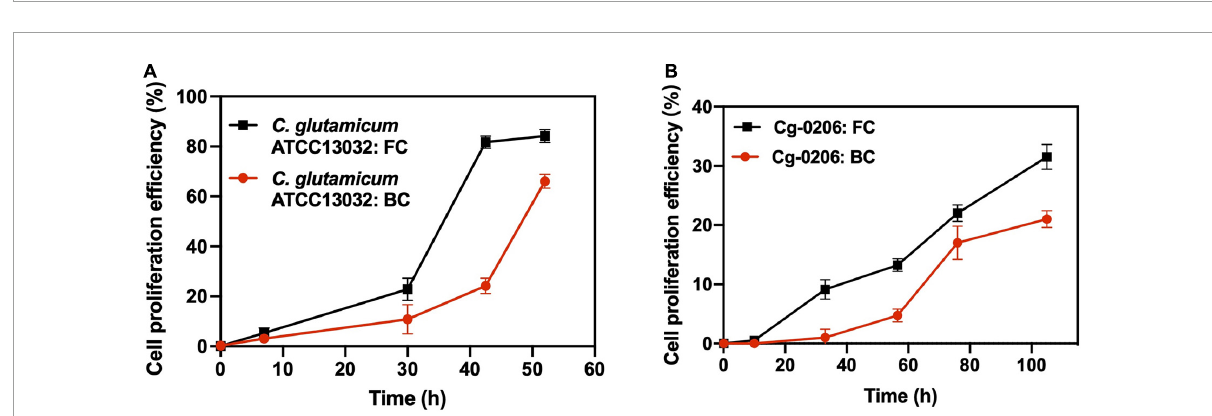
FIGURE5 Comparison of cell proliferation efficiency between biofilm cells (BC) and free cells (FC). (A) C. glutamicum ATCC13032 cells taken at the log phase of batch 2 (59 h). (B) C. glutamicum 0206 cells taken at the log phase of batch 1 (16 h). Cells were collected and stained with CFDA-SE, and then resuspended into fresh culture medium (0 h) for proliferation. Dilution of fluorescence was recorded at predetermined time intervals using FCM. Cell proliferation efficiency was defined as the percentage of cells whose fluorescence intensity fell into the control region ( Supplementary Figure 4